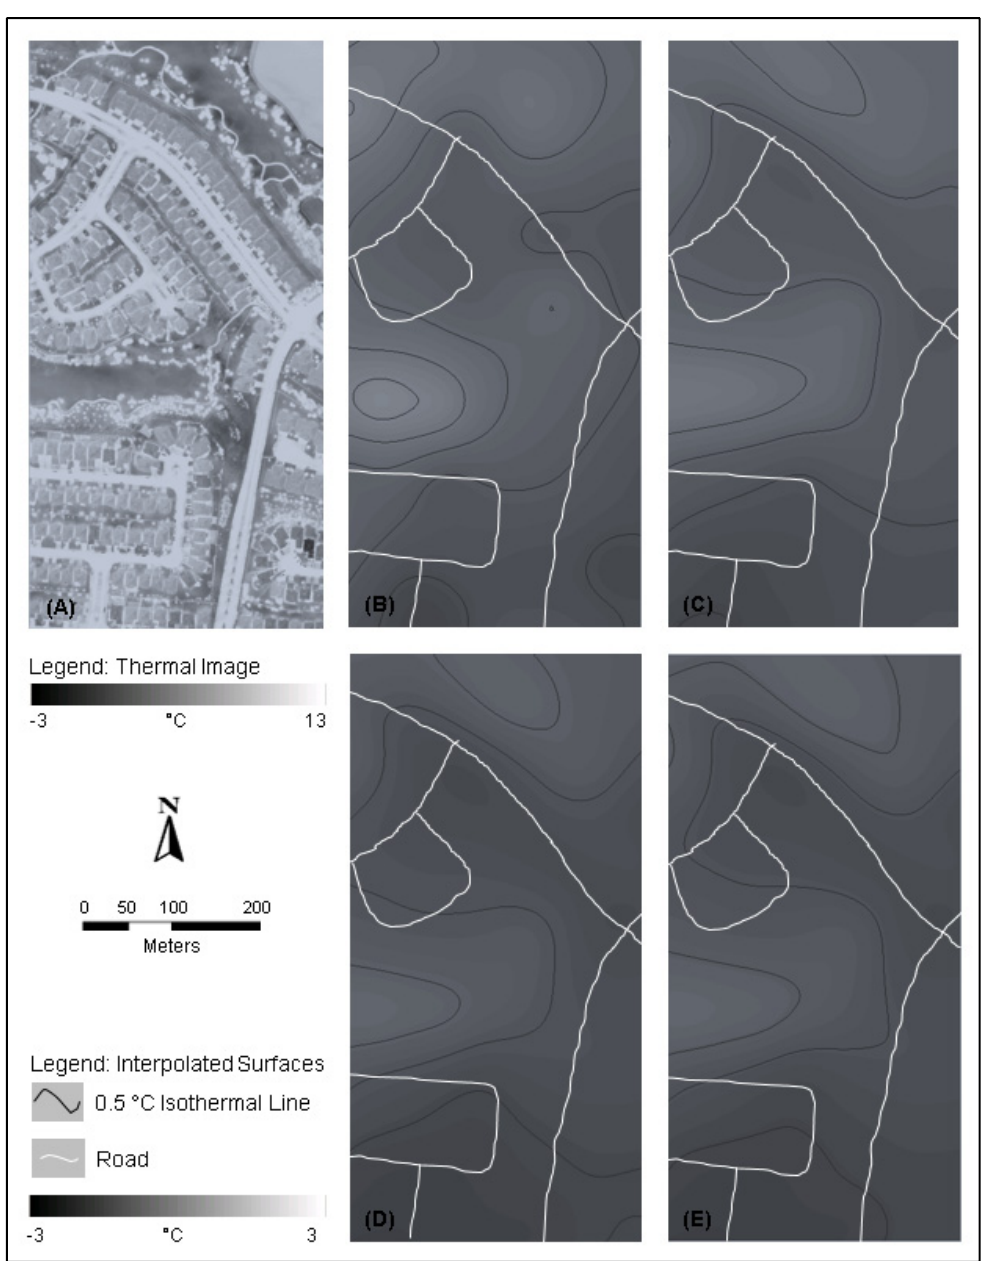
Figure 10. In this figure, ( A ) illustrates a portion of the original TIR flight-line composed of buildings, roads, grass, etc. Dark tones are cooler, bright tones are warmer. ( B – E ) illustrate four interpolated TURN-surfaces that represent continuous urban microclimate temperature variability surfaces (°C), derived from local TIR road-objects, at four